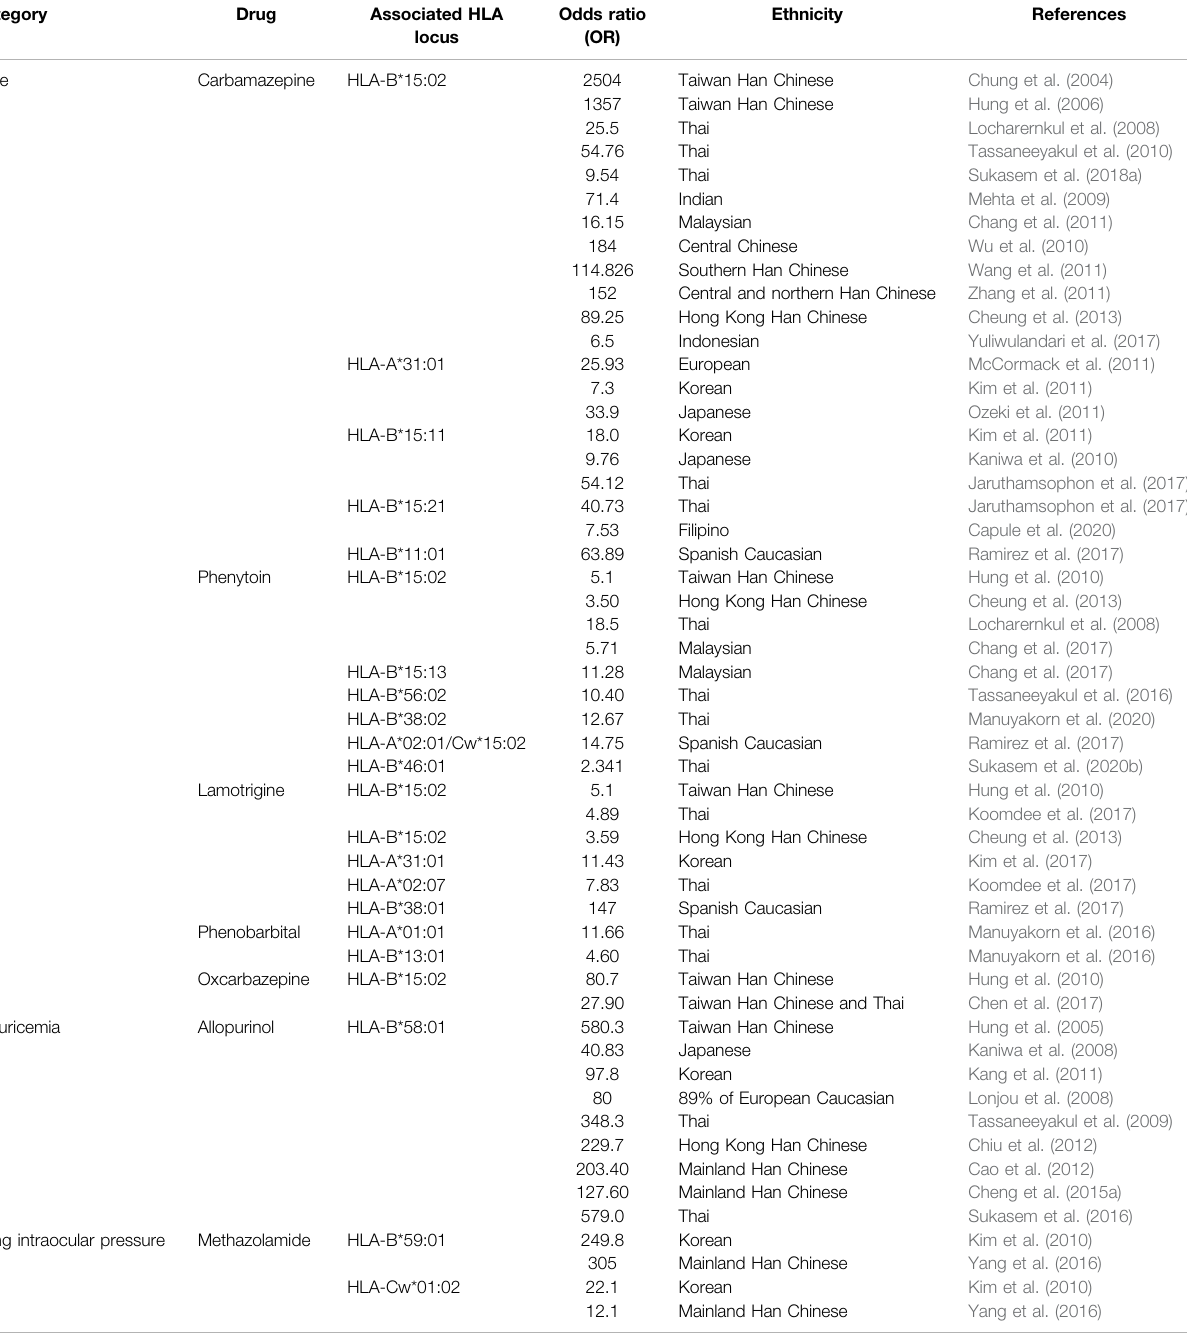
TABLE 1 | Selected drug-induced SJS/TEN and their association with